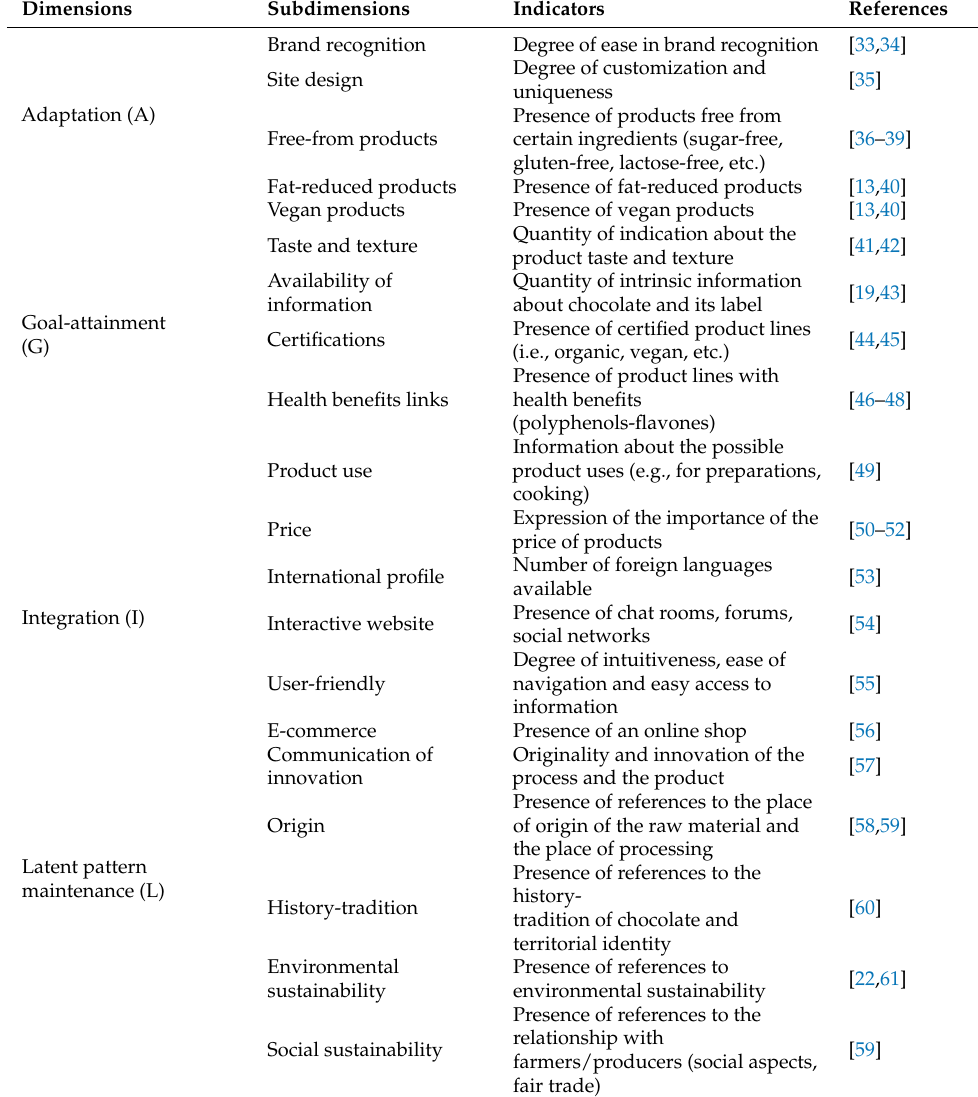
Table 1. AGIL scheme: indicators and subdimensions referring to each dimension of the AGIL scheme.